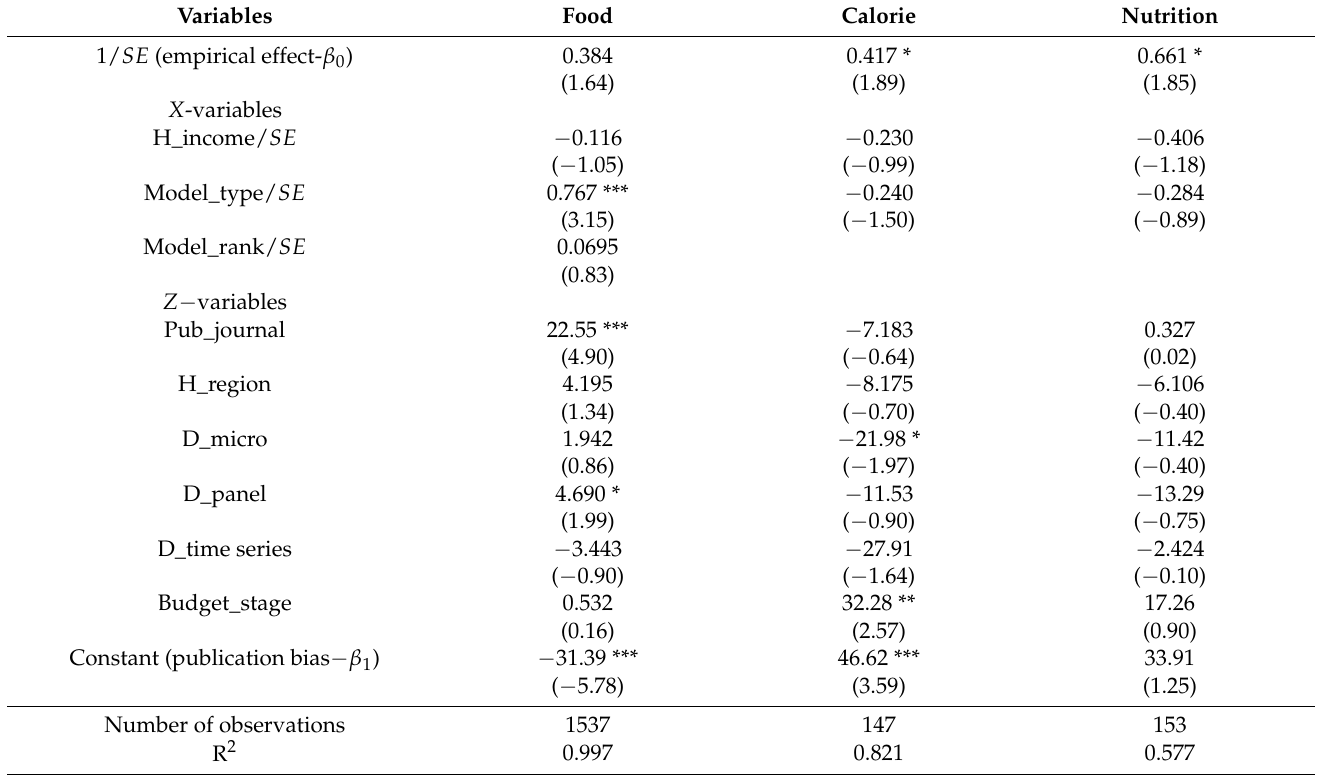
Table 3. The results of